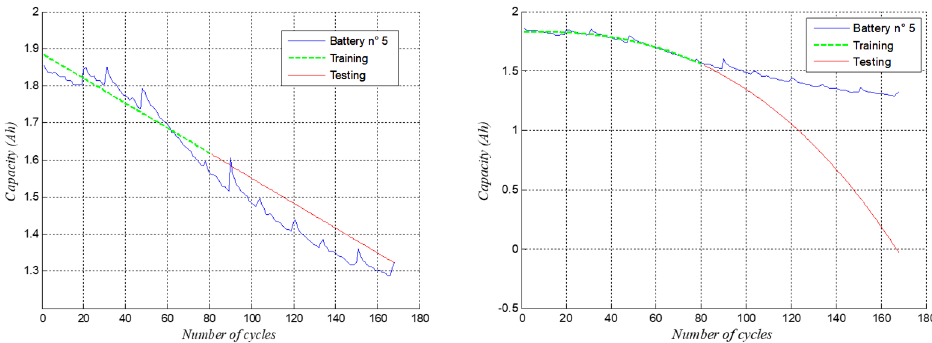
15 of 18 Figure 18. IGBT component predicted RUL. Reproduced from [17], IEEE. 5.4. Power Storage Systems: Predicting Battery Discharge The lithium-ion battery degradation experiment data used in this application are from the NASA Ames PCoE [1,11]. In this work, Battery #5 from the NASA dataset was used. The capacity degradation experimental results of Battery #5 based on linear regression, polynomial regression are shown in Figure 19 (left) and (right), respectively